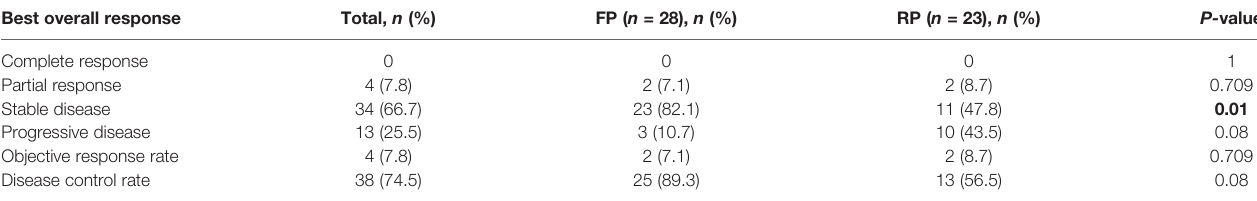
TABLE 2 | Curative effect evaluation.